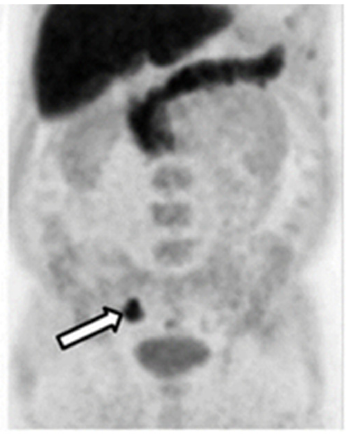
Figure 4. A [ 18 F]fluciclovine PET/CT image of PCa (white arrow). This research was originally published in the Journal of Nuclear Medicine (JNM) [36].